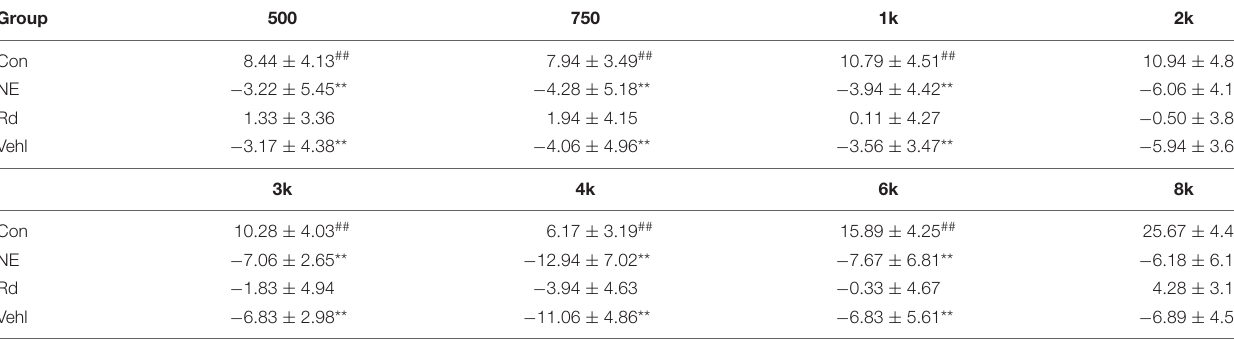
TABLE 3 | DPOAE amplitudes of guinea pigs in each group after 1 h noise exposure (dB, n = 24). Group 500